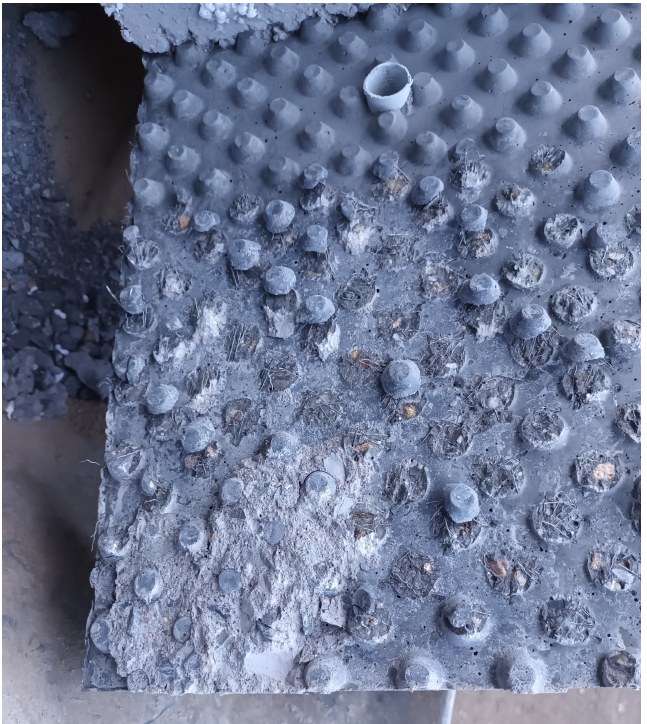
Figure 10. In the specimen, the buttons were sheared off in most of the area, but in some parts crack occurred in the filling